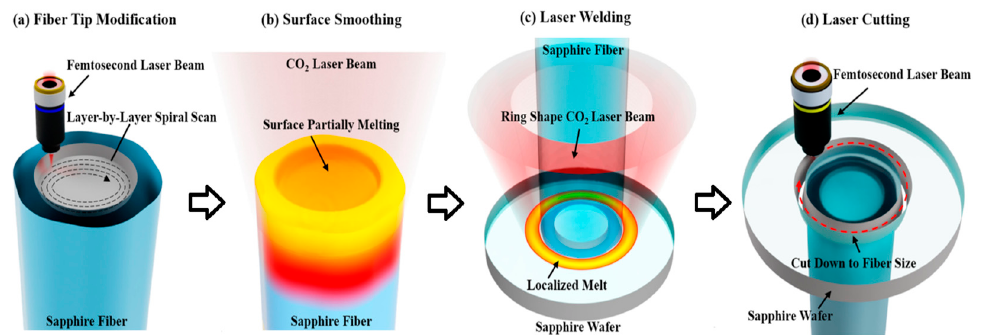
Figure 9. Schematic diagram of the all-sapphire FPI fabrication process. (Reprinted with permission from Ref. [118].) ( a ) Machining a 12 μ m deep pit with 90 μ m diameter on the end face of a sapphire fiber using fs laser; ( b ) Hydrofluoric acid immersion and CO 2 laser heating to reduce the reflective surface roughness; ( c ) Laser welding technique to weld a sapphire wafer of 30 μ m thickness and 350 μ m diameter to the fiber; ( d ) Femtosecond laser excision of excess sapphire wafer.